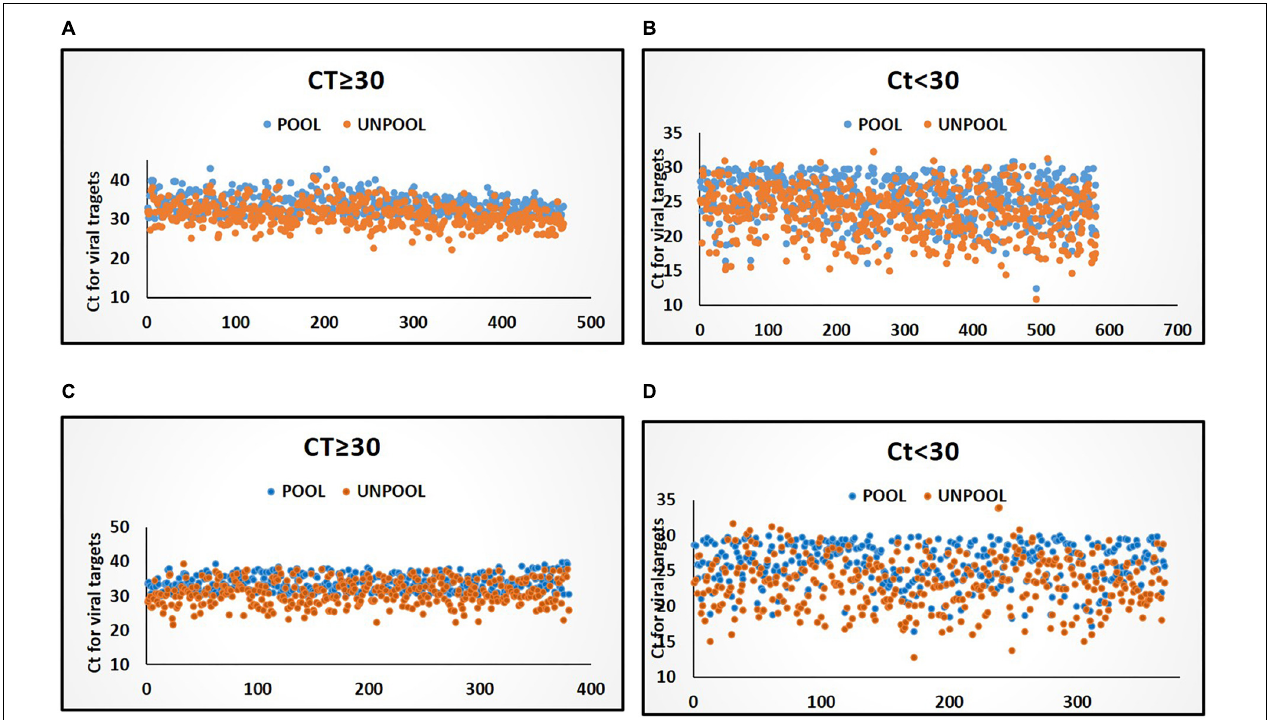
FIGURE 2 | Distribution of Ct values for viral target in pools and deconvoluted samples with only one positive sample in deconvolution. (A) Distribution of Ct values ( ≥ 30) in the P-5 testing strategy. (B) Distribution of Ct values in ( < 30) in P-5 testing strategy. (C) Distribution of Ct values ( ≥ 30) in P-10 testing strategy. (D) Distribution of Ct values in ( < 30) in P-10 testing strategy. Blue and orange color markers indicate Ct of viral targets in pools and in deconvoluted samples,